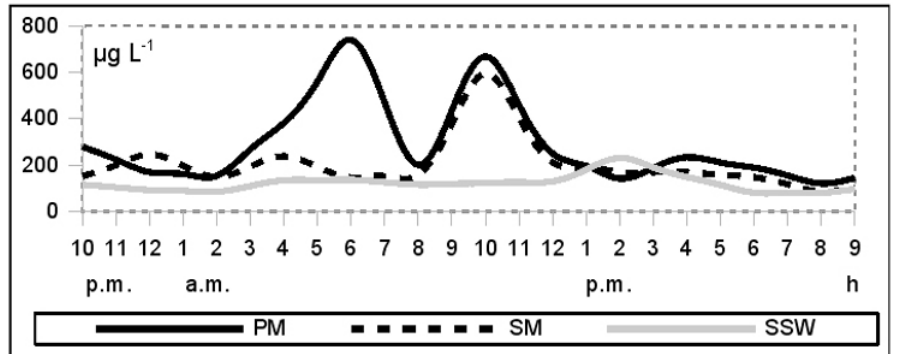
Figure 2. Diurnal variation in the concentration of total phosphorus (µg L -1 ) in surface microlayers and subsurface water of Lake Dołgie Wielkie